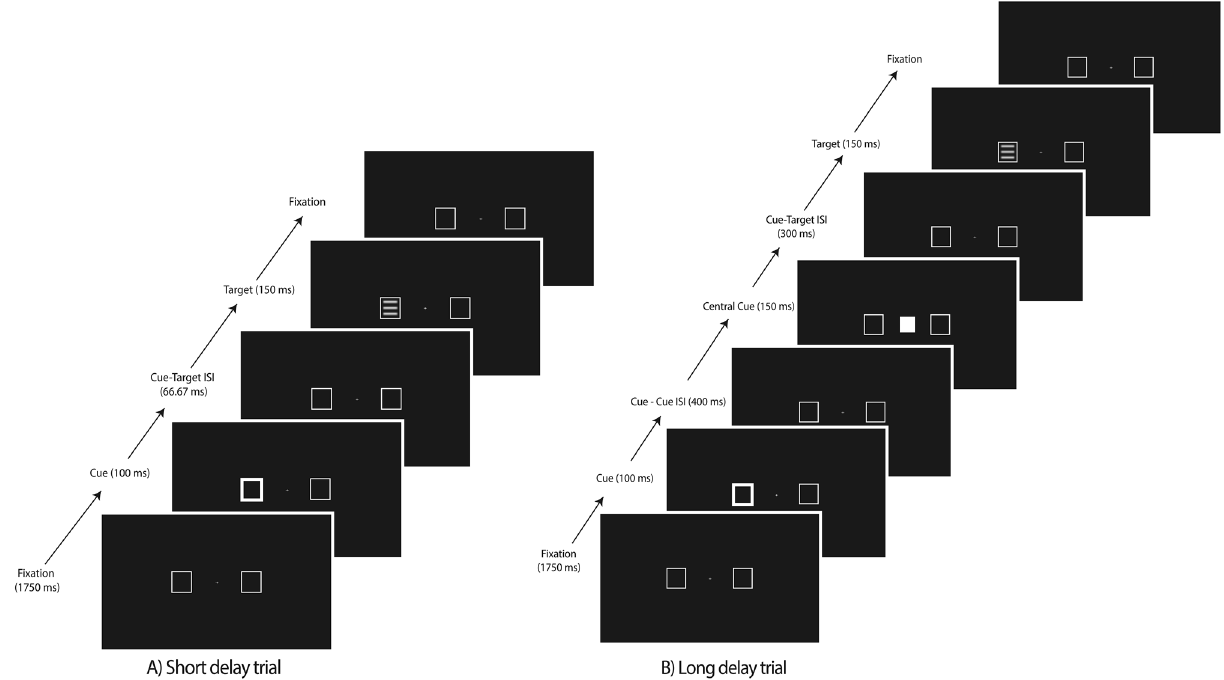
Figure 3. Sequence and timing of stimulus events in the attentional cuing task (flash cue) in Study 1. Trial- sequence for the ( A ) validly-cued at the left location for the short cue-target delay, and the ( B ) validly-cued at the left location for the long cue-target delay is shown. ISI = interstimulus interval. Participants were able to input their response at the final fixation panel. Max response time allowed = 1000